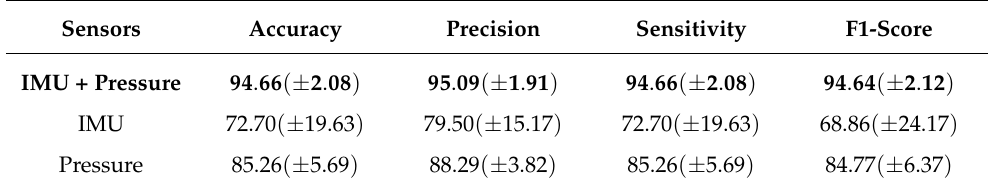
Figure 4. Number of features selected by each foot for each sensor. The hallux is the most relevant pressure sensor ( PS ), whereas, the accelerometer ( Acc ) is the most significant inertia sensor, followed by the gyroscope ( Gyr ). The x-axis of the magnetometer ( Mag ) is the only sensor in this investigation that had no bearing on the activity classification. Table 2. Summary of classification results of using the SVM and a stratified 5-fold cross-validation on different datasets. Values in the columns are the average value and the standard deviation (in parenthesis) of the corresponding performance